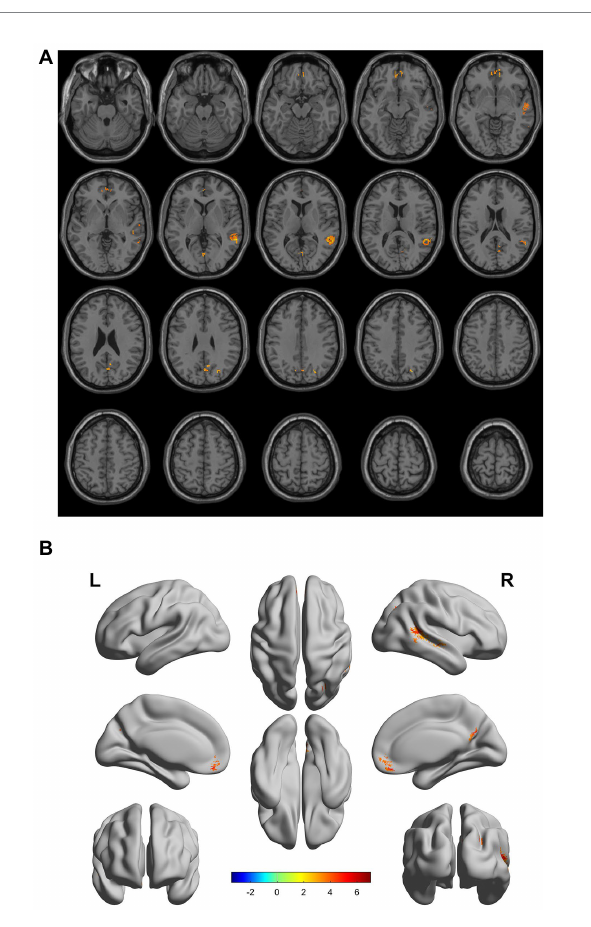
FIGURE 2 (A, B) Compared with the normal control group, the distribution of gray matter atrophy changed in the subcortical ischemic vascular disease- vascular cognitive impairment no dementia group. Orange-yellow shows the areas of